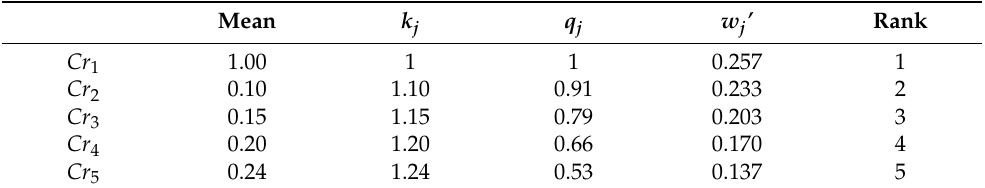
Table 2. Computational details and criteria weights generated by the SWARA method based on mean values.